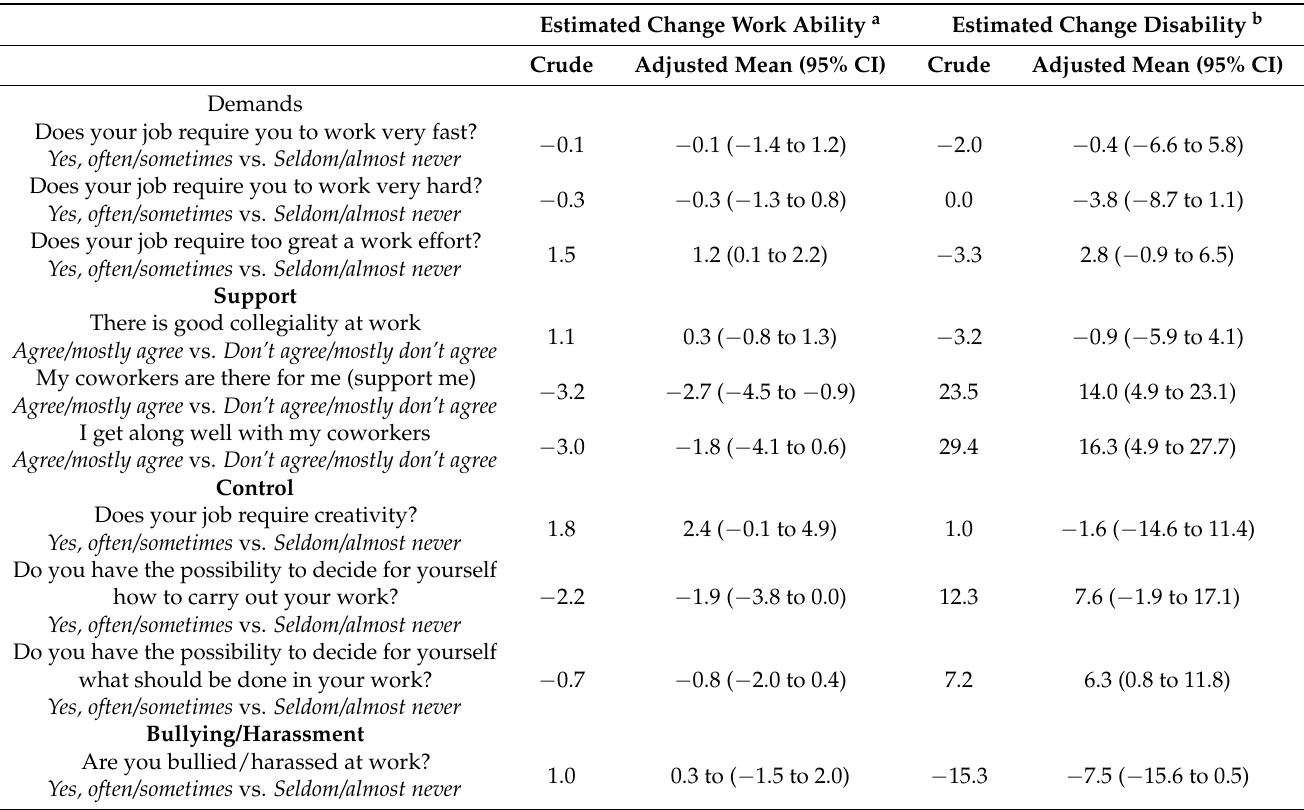
Table 4. Association between work environment (single items of Demand Support Control ques- tionnaire) and work ability and disability measured at baseline, three and nine months for patients receiving physiotherapy treatment. Estimates reflect the mean change in the outcome variables per unit change (category change) in the demand, support and control